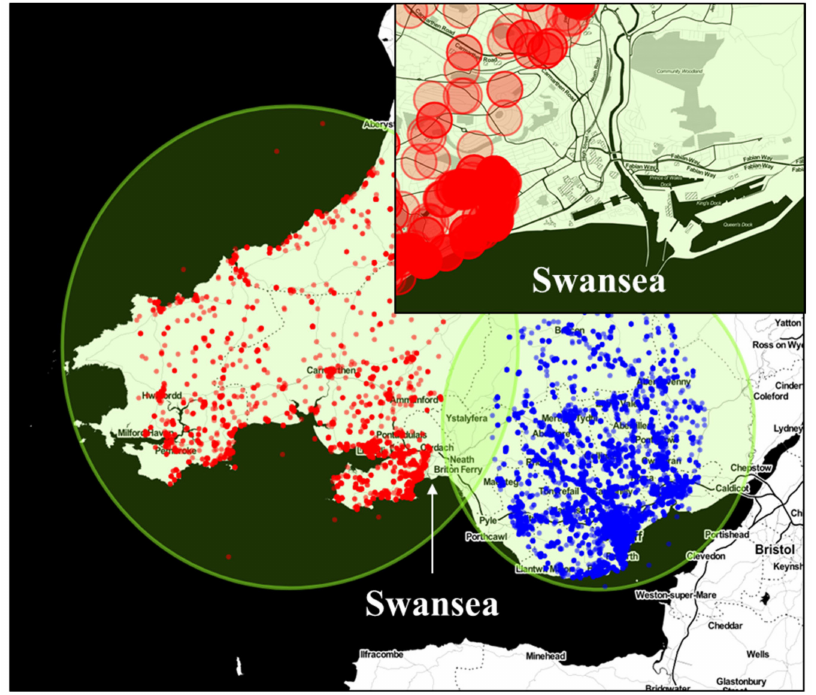
Figure 2. The “circle coverage